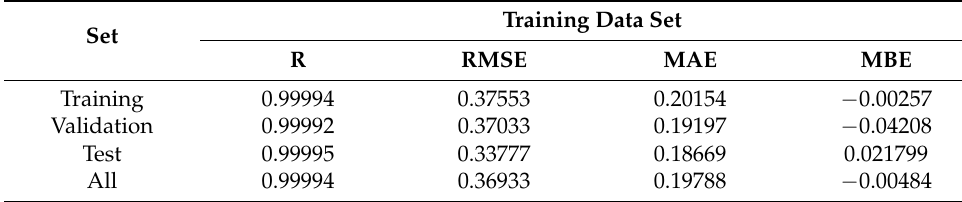
Table 4. Statistical parameters of the (5-15-10-1) ANN model.